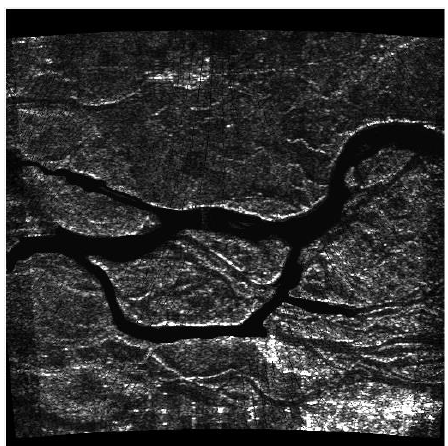
Fig. 1. Radar image of the earth’s surface before non -linear processing.